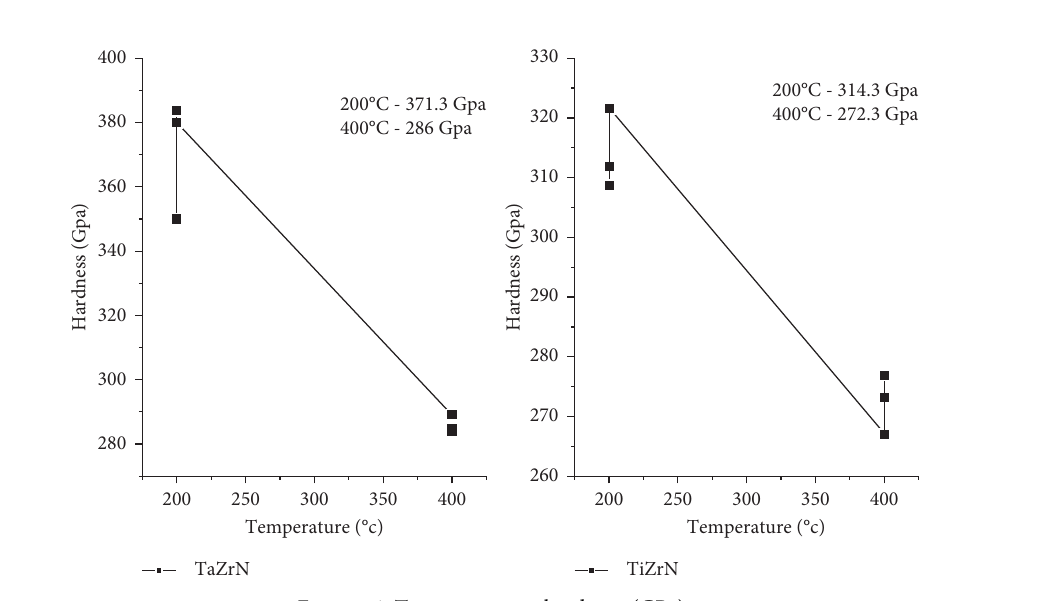
Figure 6: Temperature vs hardness (GPa).